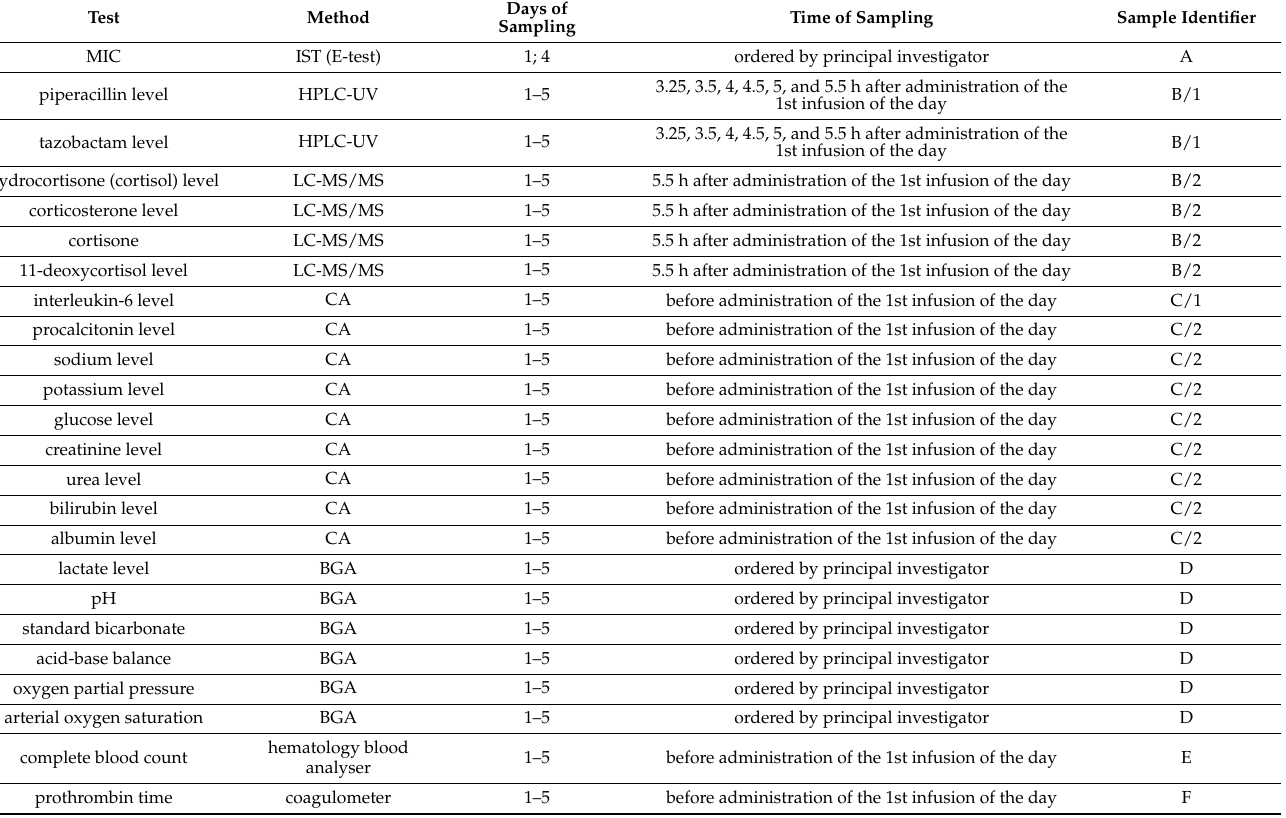
Table 2. Laboratory values established in the participants. (A) Tracheal secretion; (B) and (C) tubes of venous native blood; (D) 1 tube of venous, heparinized blood; (E) 1 tube of venous, EDTA-treated blood; (F) 1 tube of venous blood treated with sodium citrate. BGA: blood gas analyzer, CA: clinical analyzer, HPLC-UV, high performance liquid chromatography with absorbance detection, INR: international normalized ratio, IST: in vitro susceptibility test, LC-MS/MS: liquid chromatography-tandem mass spectrometry, MIC: minimal inhibitory